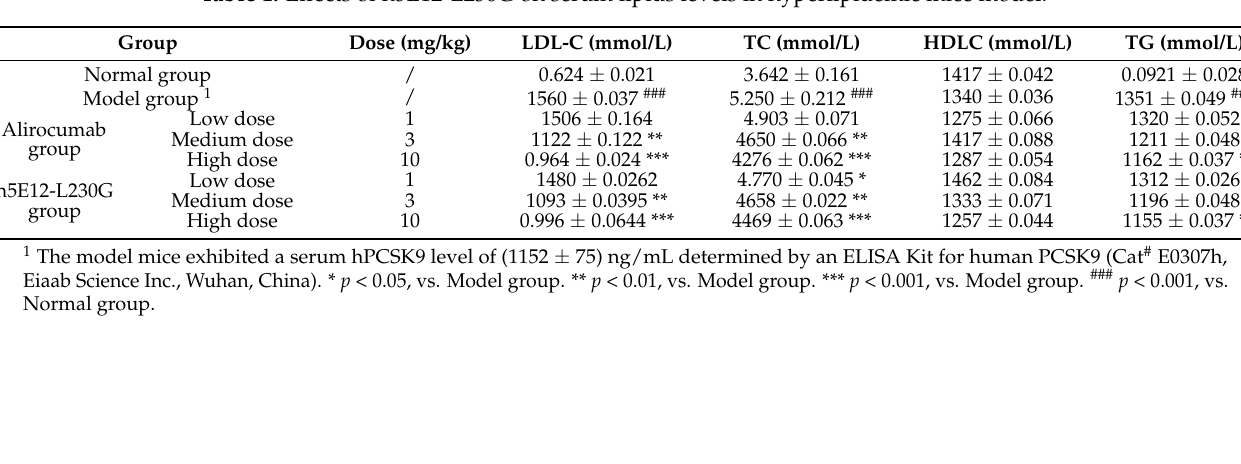
Table 1. Effects of h5E12-L230G on serum lipids levels in hyperlipidemic mice